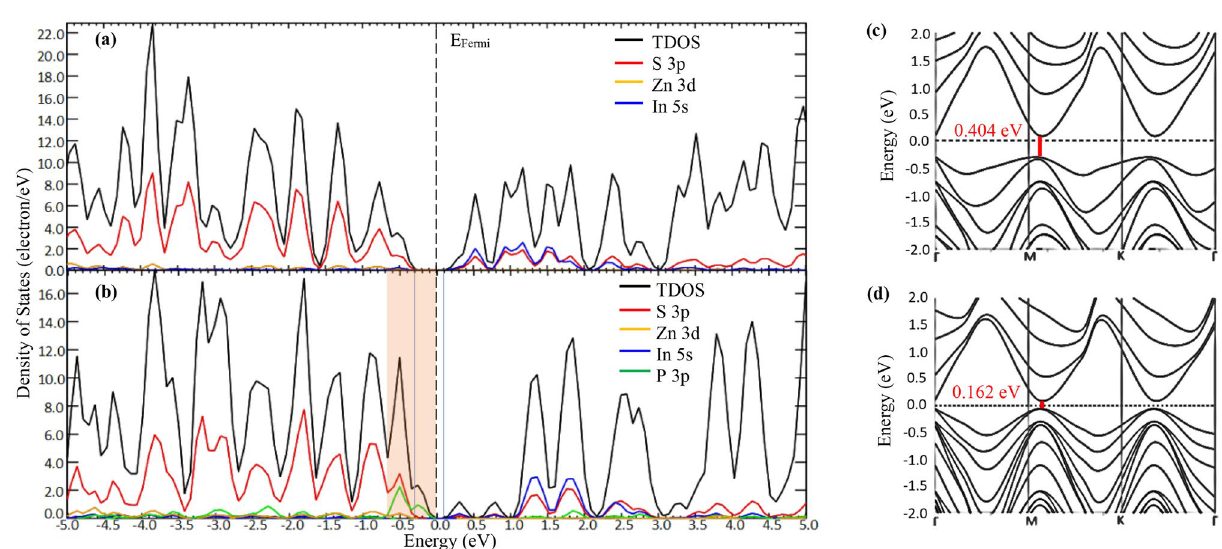
Figure 3. Calculated DOS of ( a ) pristine ZIS, and ( b ) P-ZIS (SPD-3). E Fermi = Fermi level (set to 0 eV). Vertical blue lines represent VBM and CBM of pristine structure respectively for comparison. Light orange shading marks the increased DOS at VBM due to P-doping. Calculated band structures of ( c ) pristine ZIS and ( d ) P-ZIS (SPD-3) near VBM and